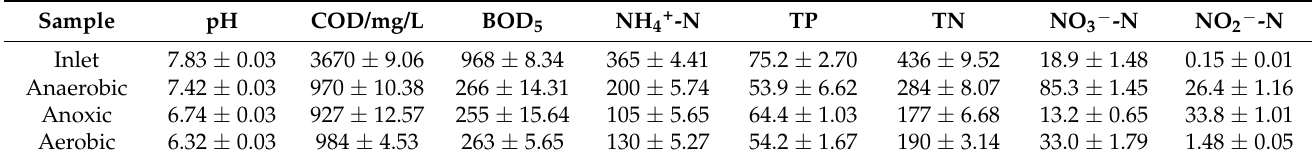
Table 1. Characteristics of wastewater quality in each unit